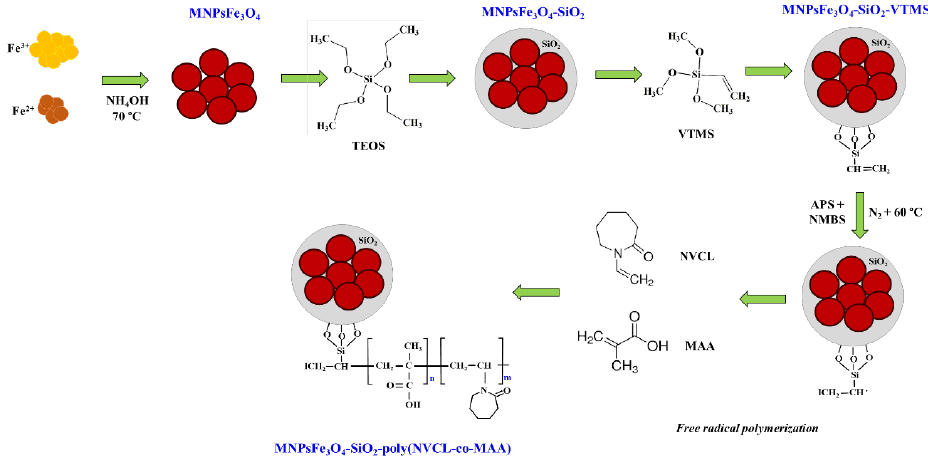
Figure 1. Synthesis route of MNPsFe 3 O 4 -SiO 2 -poly(NVCL-co-MAA).